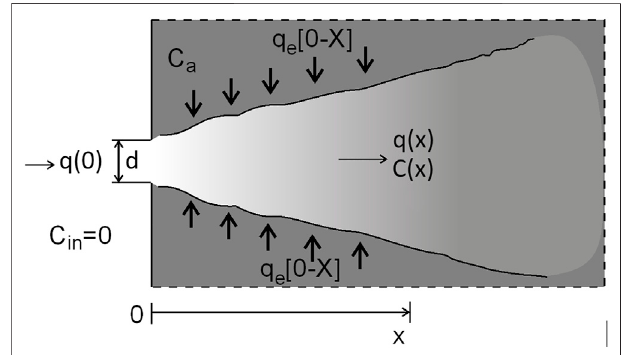
FIGURE 8 | Jet immersed in ambient air with uniform concentration C